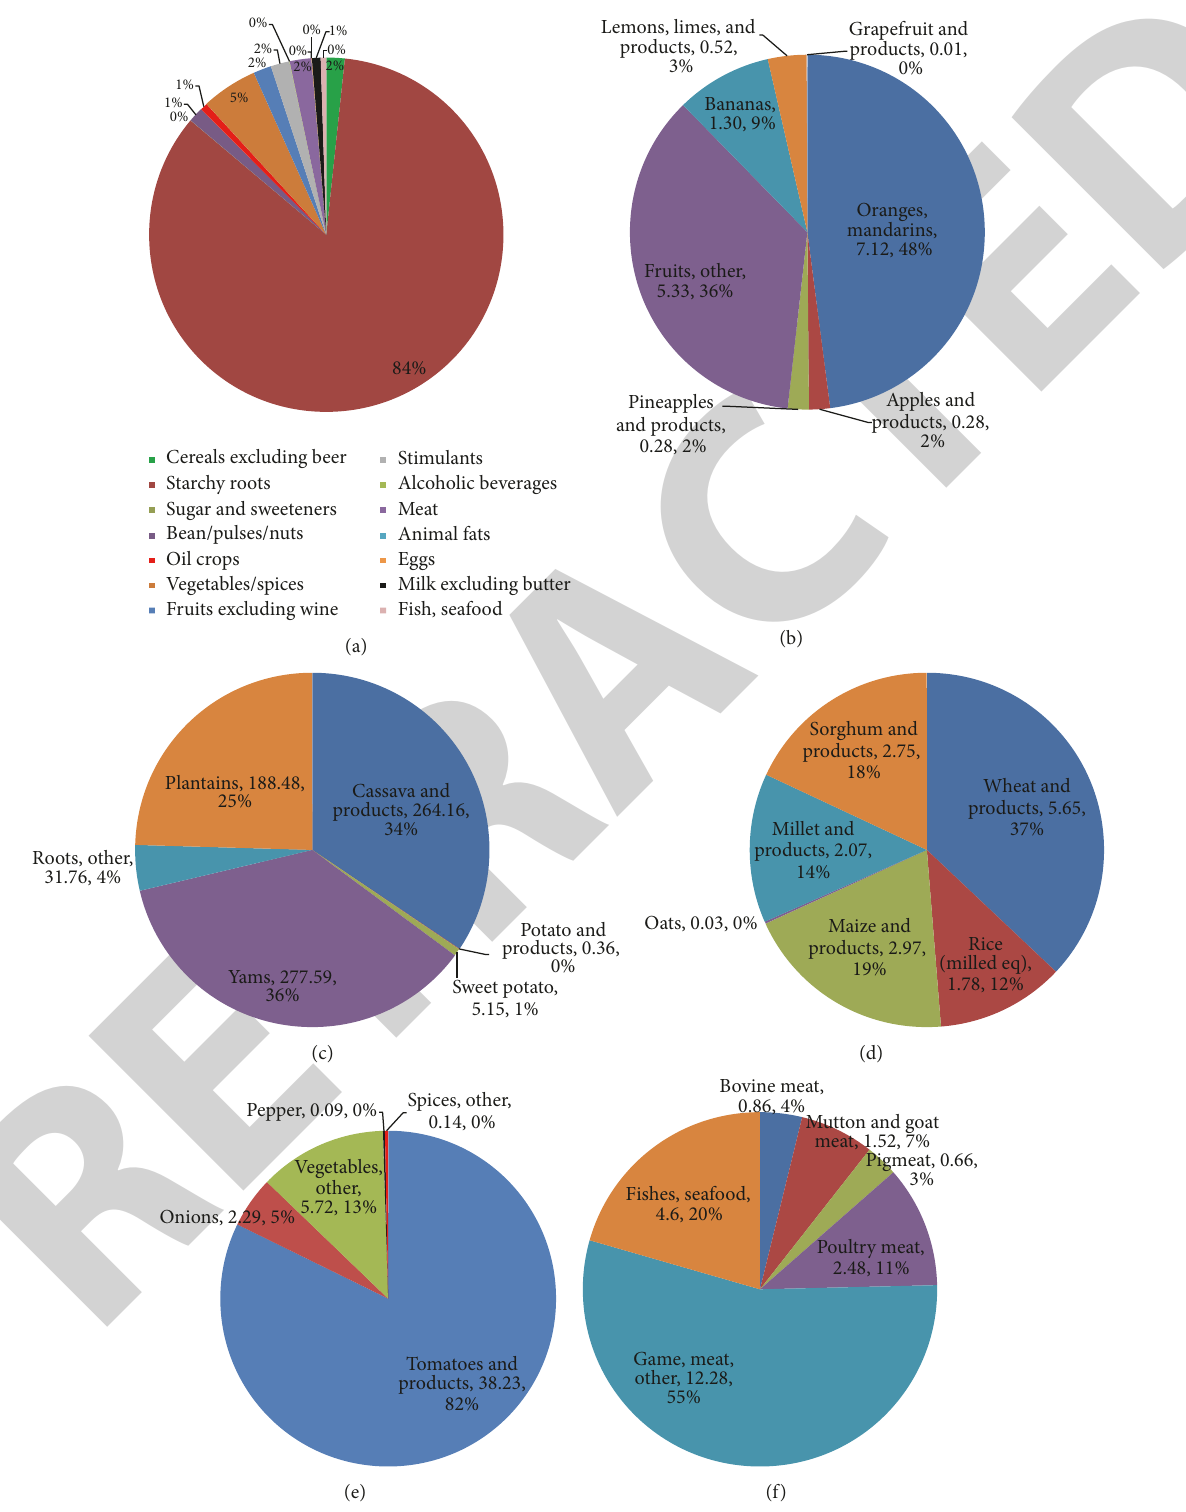
Figure 1: Contribution of food items to total K supply for Ghana based on 2010-2011 average food supply